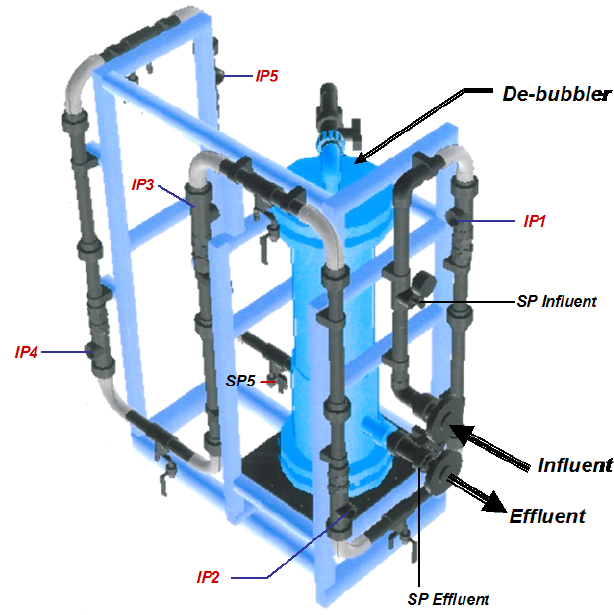
Figure 1. Peroxone loop reactor with injection points (IPs), sample points (SPs) and de-bubbler contact chamber.